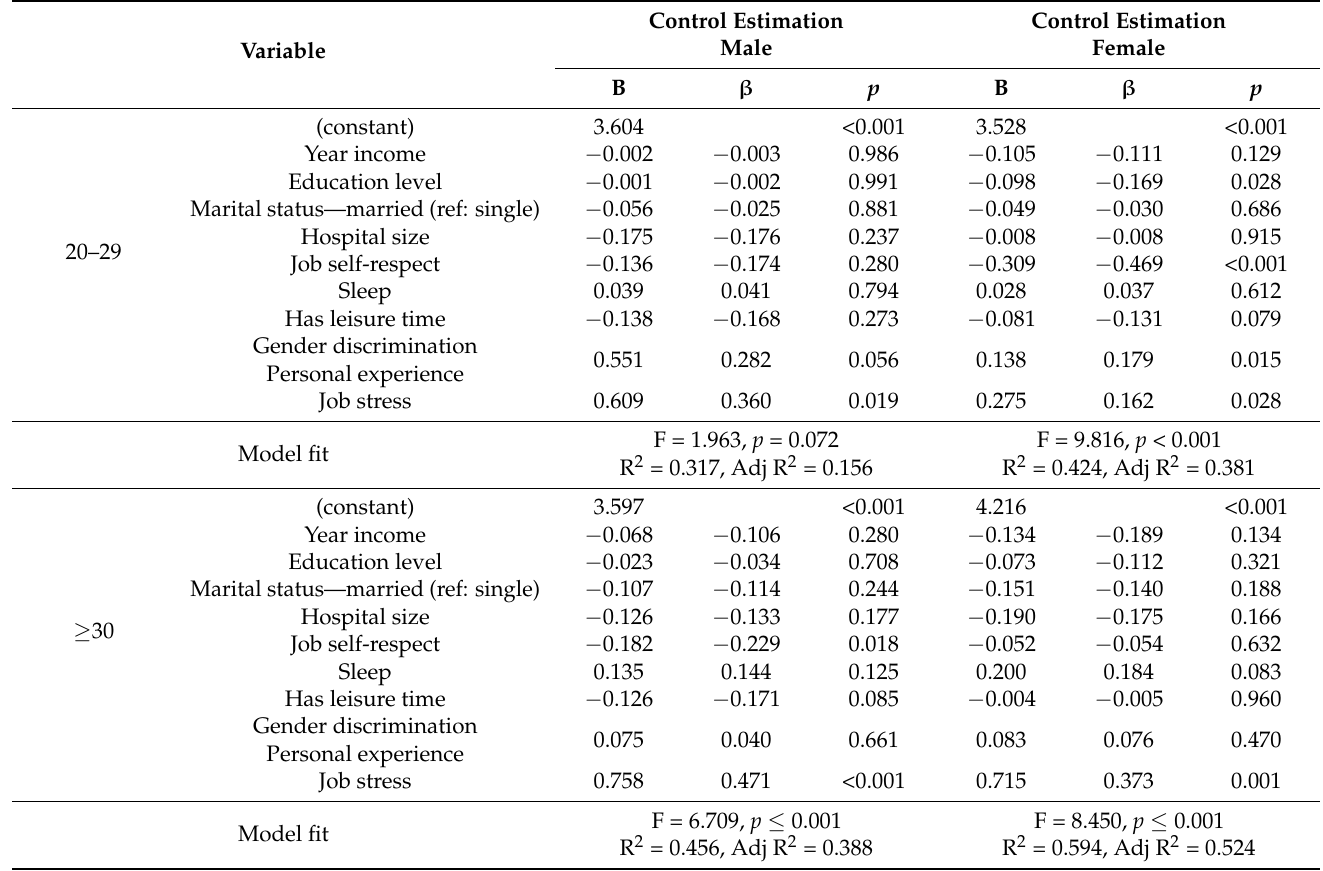
Table 4. Regression analyses explaining